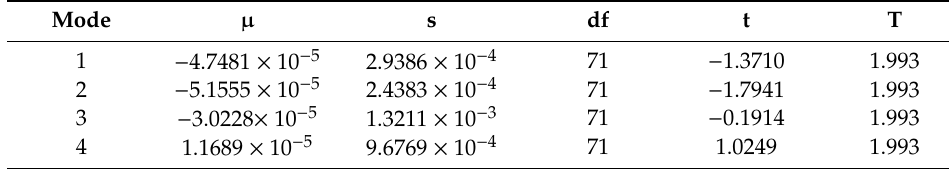
Table 4. Hypothesis test results of the training sample.